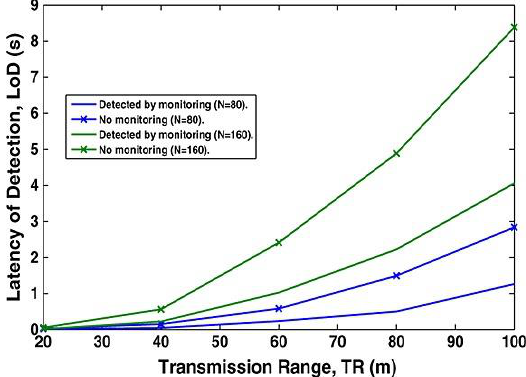
Table 3. Cost of Reduction, CoR, at